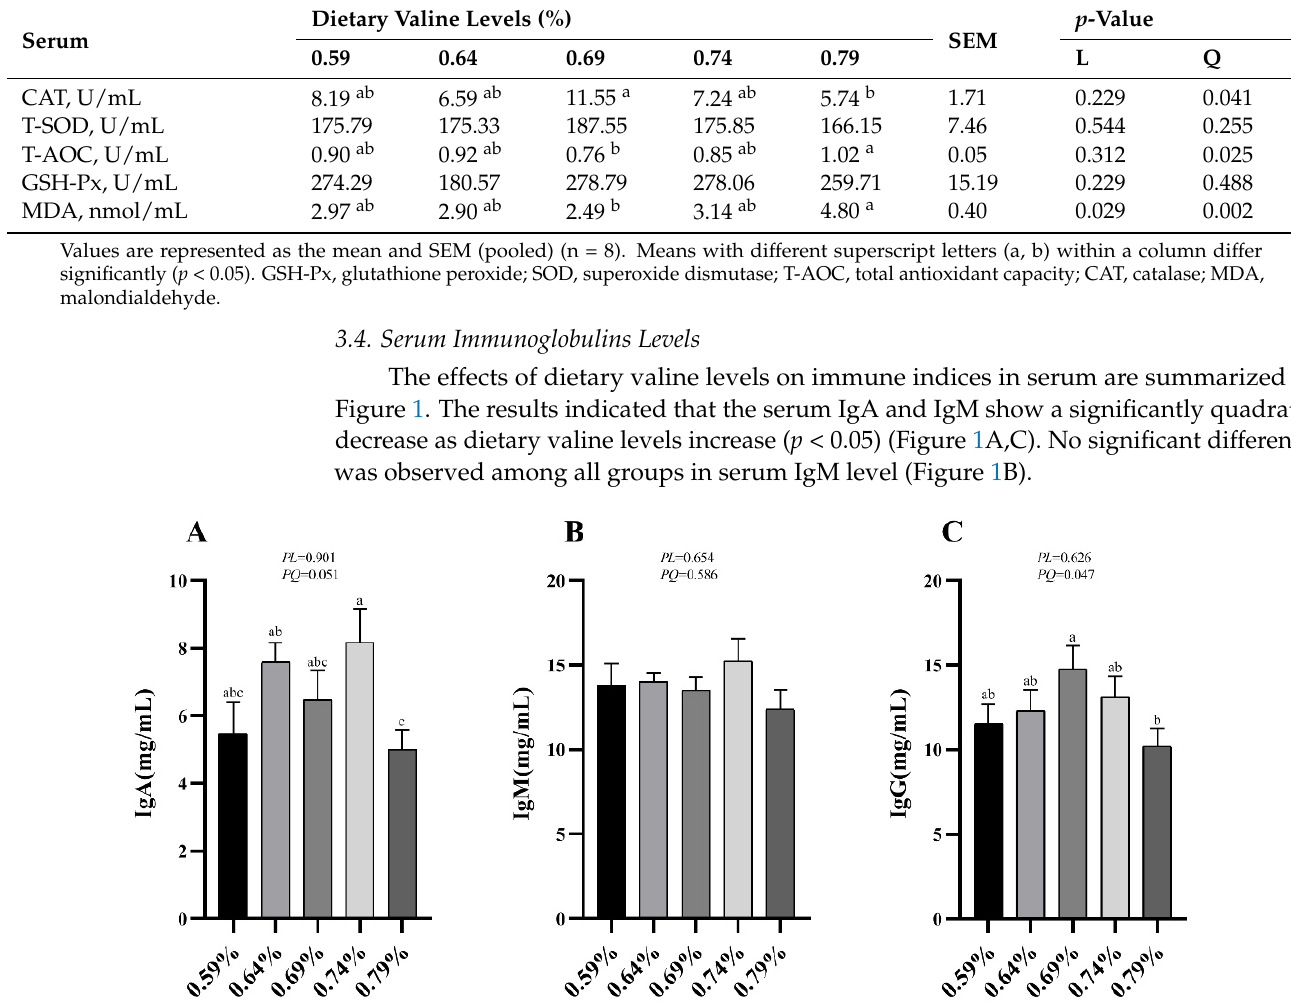
Figure 2. Effects of dietary valine levels on activities of duodenum digestive enzymes of laying hens. Values are repre- sented as the mean and SEM (n = 8). Means with different superscript letters ( A – C ) within a column differ significantly ( p < 0.05). 3.6. Serum Free Amino Acids The effects of dietary valine levels on the serum free amino acids of laying hens are presented in Table 6. As shown in Table 6, serum free Ile, Lys, Phe, Val, and Tyr showed a quadratic increase with the increasing of dietary valine levels ( p < 0.05), whereas serum free Arg, His, Met, Thr, Ala (Alanine), Asp (Aspartic acid), Glu, Gly (Glycine), and Ser (Serine) were significantly decreased ( p < 0.01). In addition, the concentration of serum Leu showed a linear decrease as the dietary valine levels increased ( p < 0.05). No difference